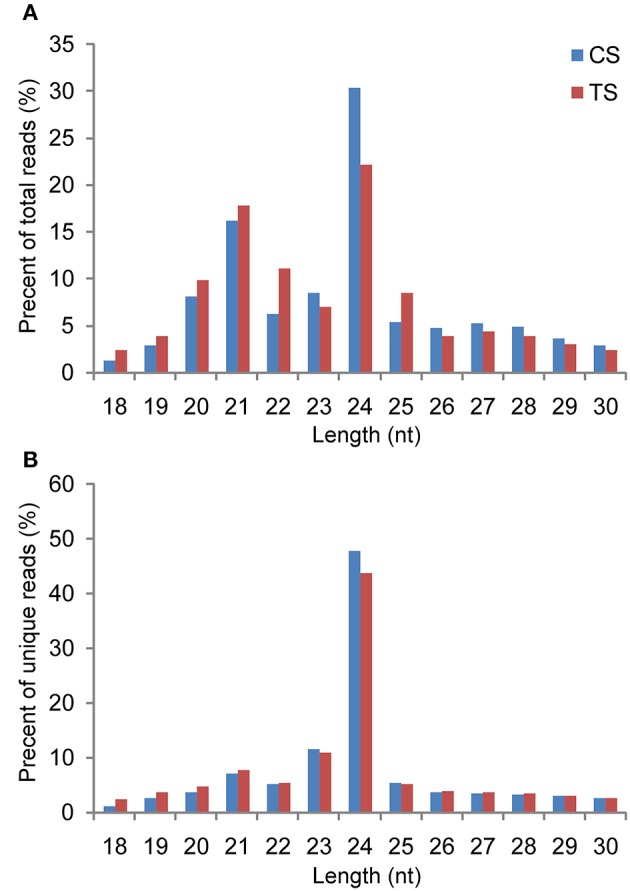
Length distribution of sRNAs detected in the control library and stress library. (A) Redundant sRNAs; (B) unique sRNAs.